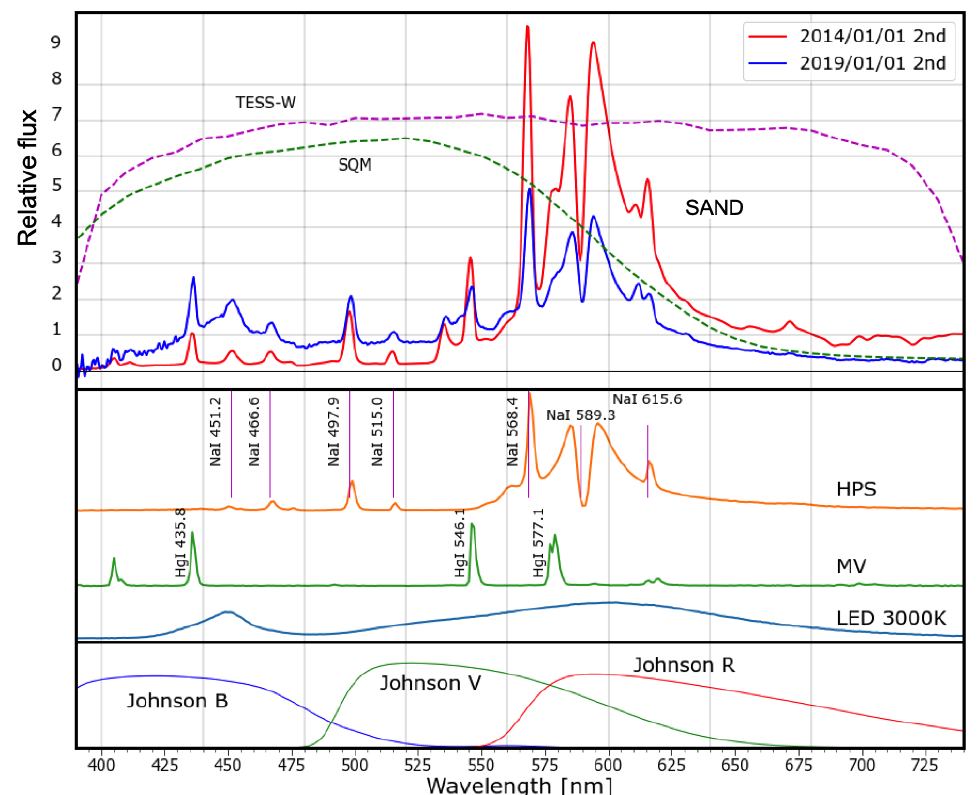
Figure 4. Spectrometer for Aerosol Night Detection (SAND) representative night sky spectra for Madrid after midnight in January of 2014 and 2019 (blue and red solid lines; upper panel). The 2019 spectrum shows the blue component of the LED spectrum that peaks at 450 nm. The upper panel also shows the TESS-W and Sky Quality Meter (SQM) spectral responses. Some prominent emission lines of typical lamps are labeled in the middle panel. The Johnson B, V, and R photometric bands are plotted in the lower panel.